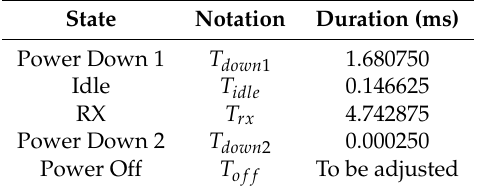
Table 4. Duration of each CC2420 radio state on a radio activation with no incoming